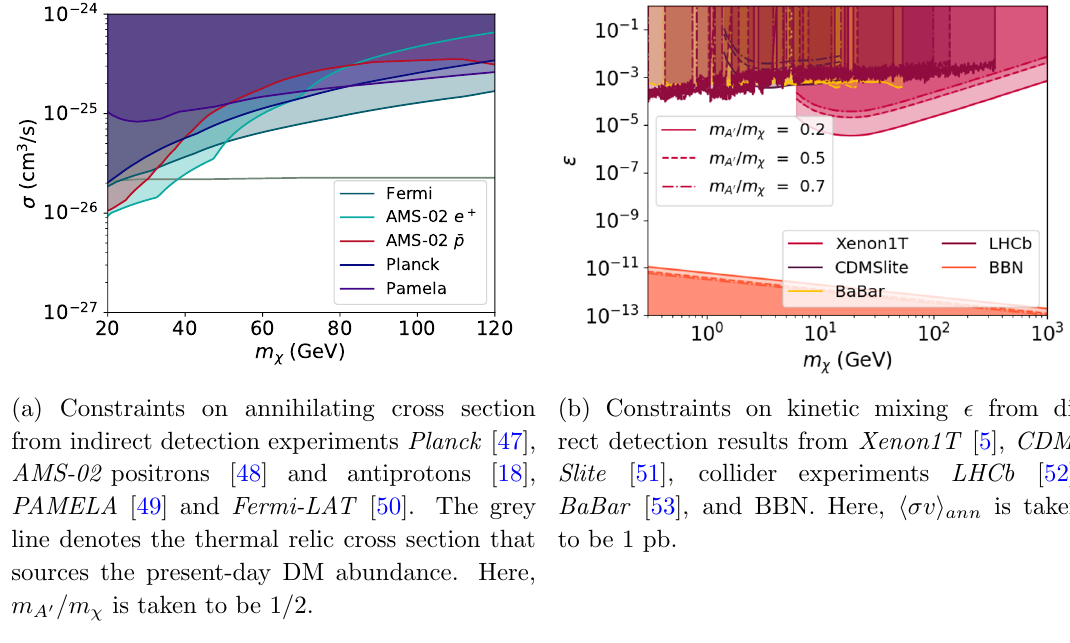
Figure 3. Constraints on dark photon dark matter parameter space from previous